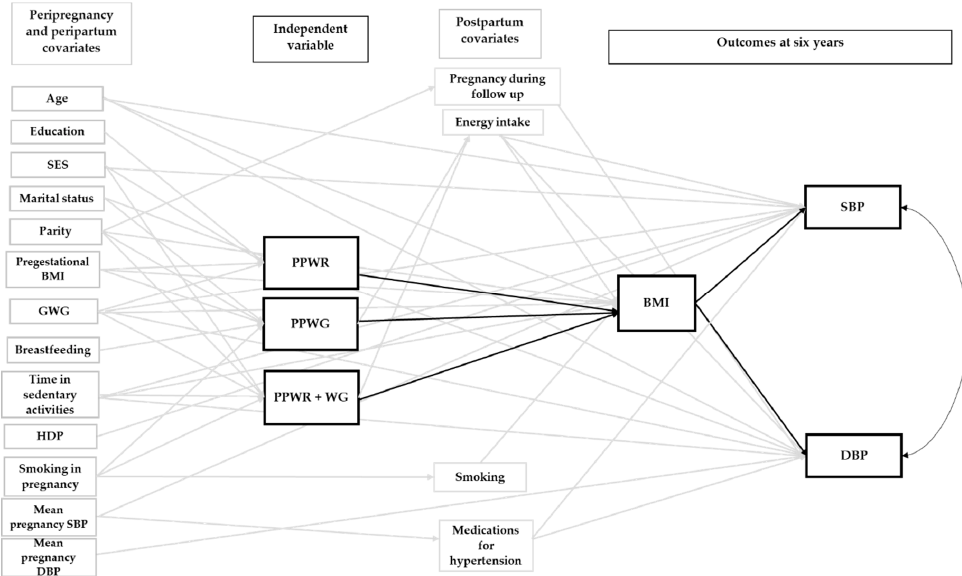
Figure 2. Final path model of the association between patterns of weight change one year after delivery and Outcome Group 2 at six years postpartum. The reference group was women who returned to their pregestational weight by one year postpartum. Arrows represent pathways among variables. The black arrows represent paths relevant to our study objectives. A continuous black arrow indicates a statistically significant association ( p < 0.05). For these outcomes, only indirect associations (mediated through BMI) were identified. BMI, body mass index; DBP, diastolic blood pressure; GWG, gestational weight gain; HDP, hypertensive disorders of pregnancy; PPWG, postpartum weight gain; PPWR, postpartum weight retention; PPWR + WG, postpartum weight retention + weight gain; SBP, systolic blood pressure; SES, socioeconomic status. Nutrients 2019 , 11 , x FOR PEER REVIEW